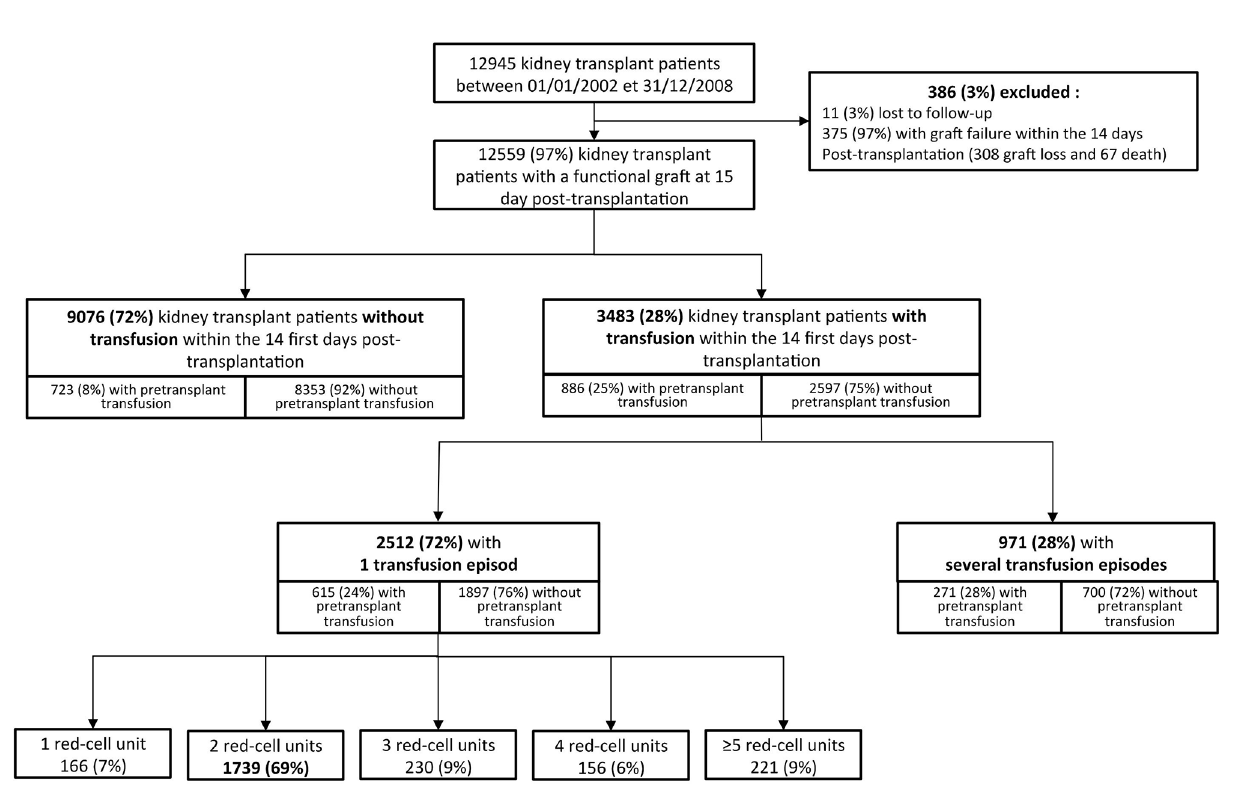
FIGURE 1 | Study patient fl ow chart. A transfusion episode is de fi ned as consecutive transfusions whose interval does not exceed 48 hours. Patients for whom follow-up does not reach 14 days post transplantation (post transplantation transfusion study period) are excluded from the study. The Figure also indicates whether patients received a transfusion in the pre and post transplantation